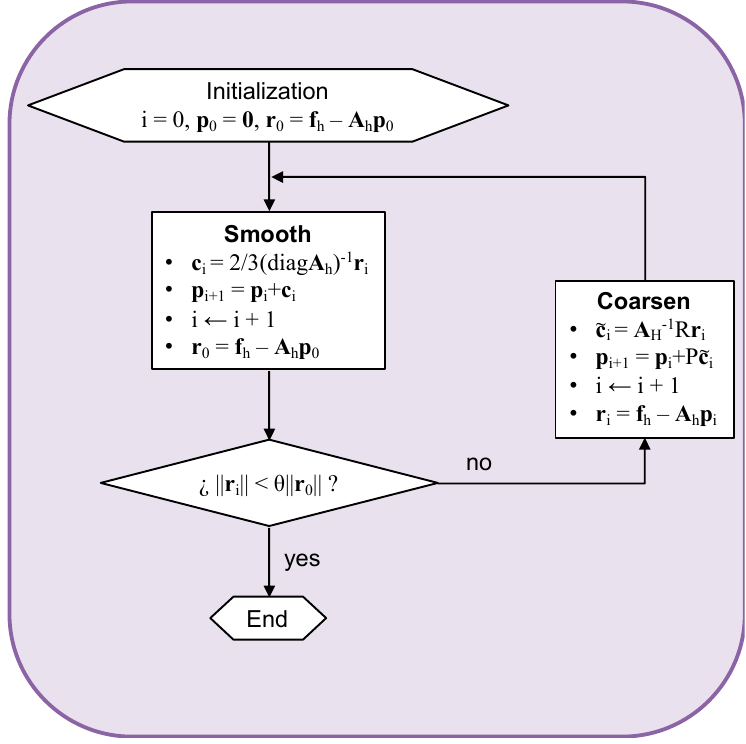
Figure 19. Multigrid scheme adapted from [120] for the Darcy problem. It consists of a two-level V-cycle with smoothing and coarsening of the solution.